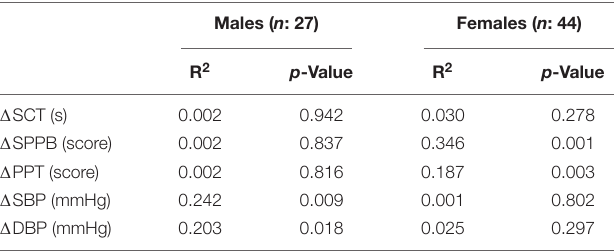
TABLE 4 | Linear regression between changes in Fat Mass ( (cid:49) FM) (kg) in adults with obesity and possible predictors. Males ( n : 27) Females ( n : 44) R 2 p -Value R 2 p